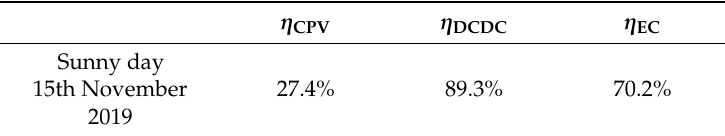
Table 2. One-day elemental e ffi ciencies on the